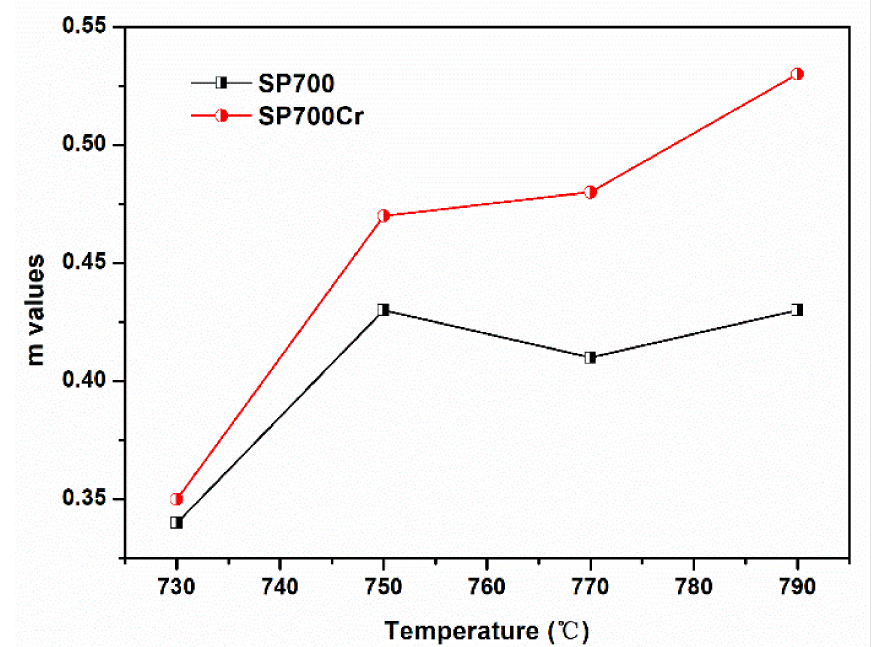
Figure 7. Strain rate sensitivity (m) values of the forged SP700 and SP700Cr alloys at different elevated